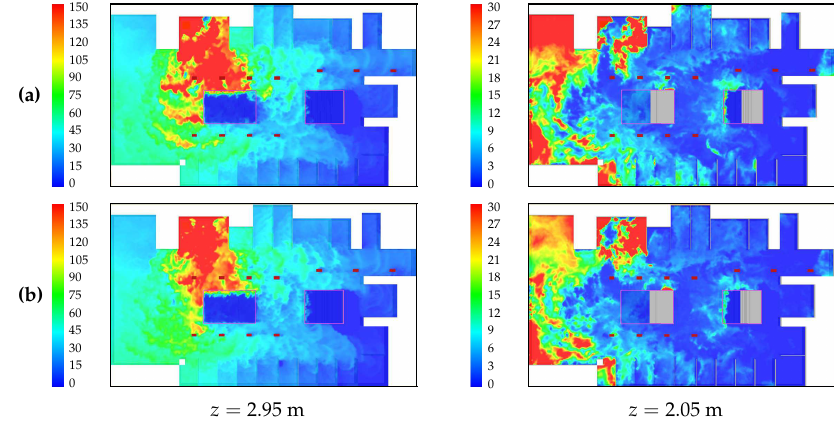
Figure 9. Temperature contours (left column) and velocity magnitude contours (right column) at t = 90 s, on the horizontal plane at z = 2.95 m, obtained as in Figure 8. ( a ) Combustion model with RADIATIVE FRACTION = 0 and ( b ) simplified fire model with T in = 2436 K (Case G-1).